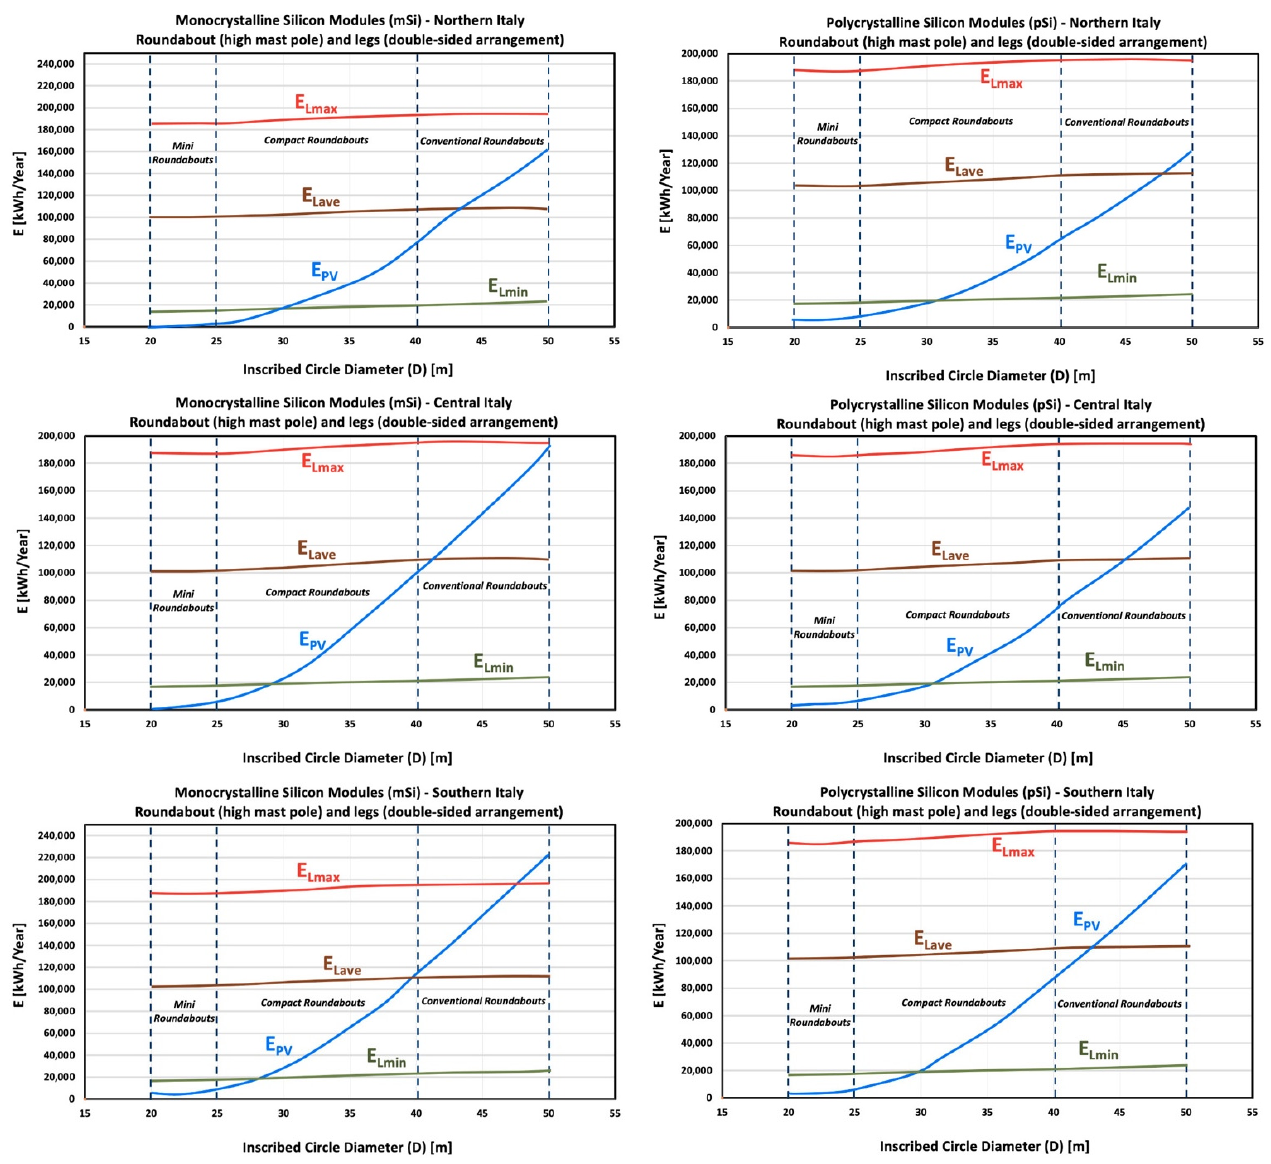
Figure 3. Comparison diagrams between the energy generated by RAPSs and the energy required by lighting systems.